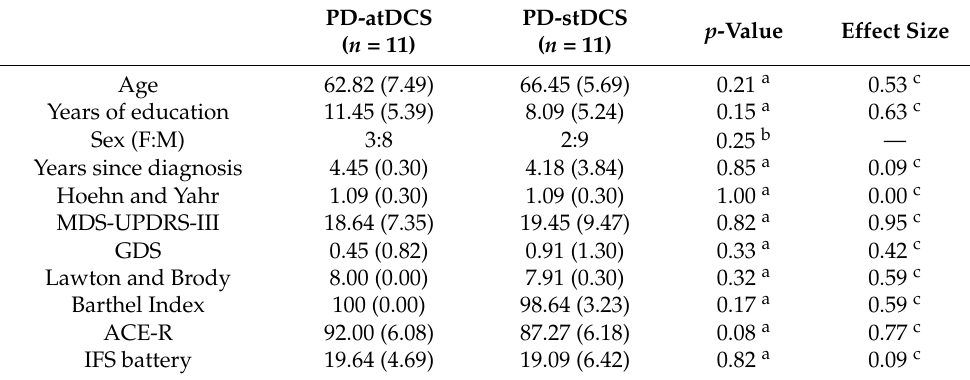
Table 1. Demographic and clinical